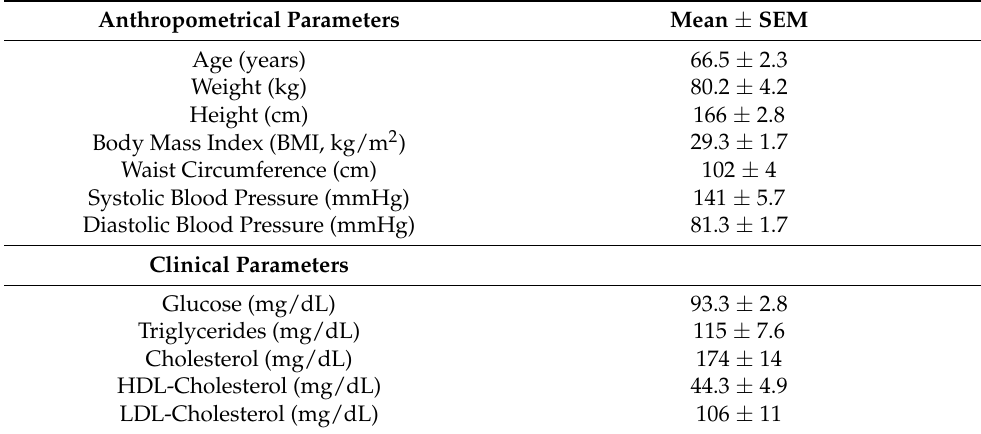
Table 1. Anthropometrical, clinical and nutritional characteristics of the